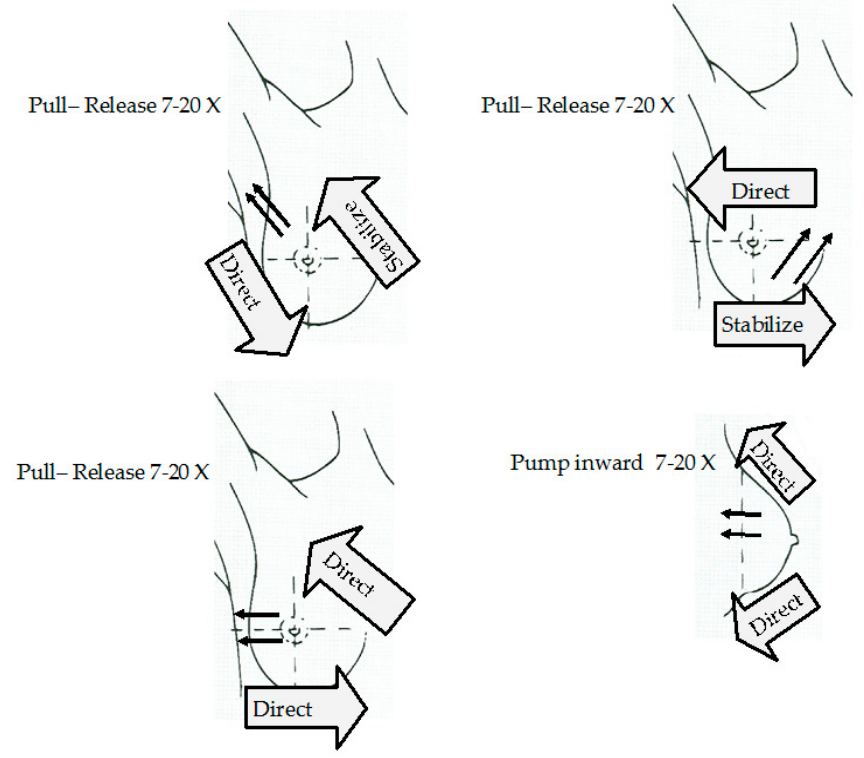
Figure 5. Diagrams showing how to perform a clinical breast examination (CBE)